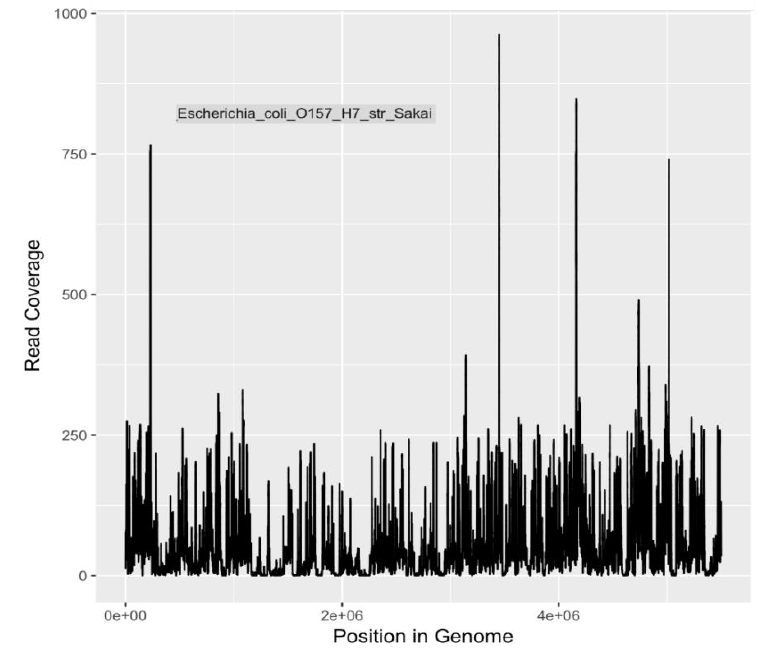
Figure 4. Sequencing coverage plot for E. coli O157:H7.